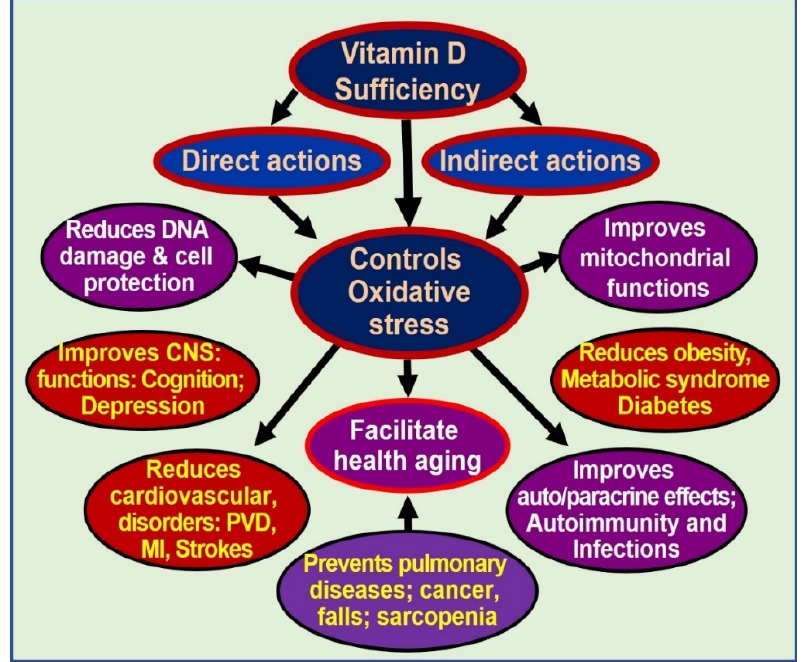
Figure 2. Oxidative stress is harmful to cells. Controlling oxidative stresses through vitamin D adequacy leads to cellular and organ protection and reduces the effects of aging [abbreviations used: CNS = central nervous system; DNA = deoxyribonucleic acid; MI = myocardial infarction; PVD = peripheral vascular diseases].